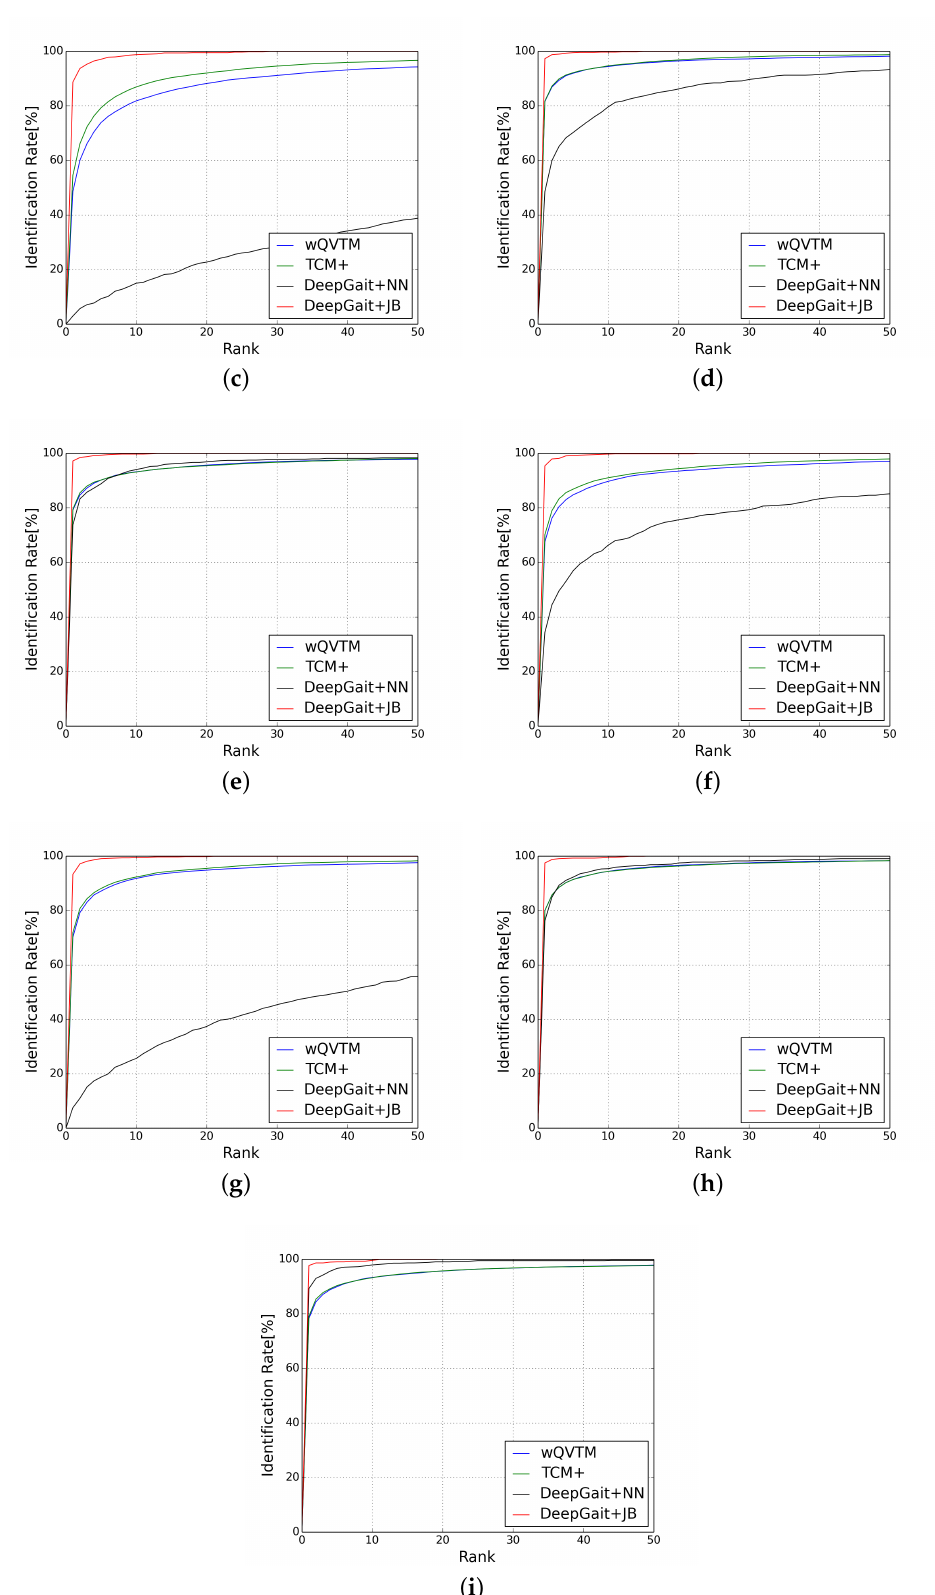
Figure 4. Cummulative Match Characteristics (CMC) curves under different cross-view settings. ( a ) G-55:P-65; ( b ) G-55:P-75; ( c ) G-55:P-85; ( d ) G-65:P-55; ( e ) G-65:P-75; ( f ) G-65:P-85; ( g ) G-75:P-55; ( h ) G-75:P-65; ( i )